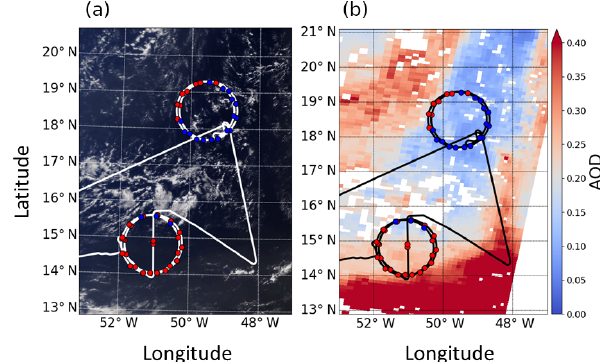
Figure 4. Flight track of RF6 on 19 August 2016 on top of the Terra MODIS (Moderate Resolution Imaging Spectroradiometer) true color image (a) and the MODIS aerosol optical depth (AOD) product (b) at 13:40UTC. Launched dropsondes are marked by col- ored dots (red dots: mineral dust laden regions, blue: dust free re-